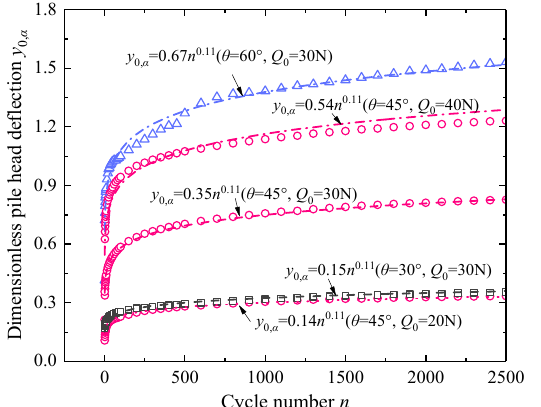
Figure 12. Developments of dimensionless pile head deflection with cycle number in cyclic lateral loading